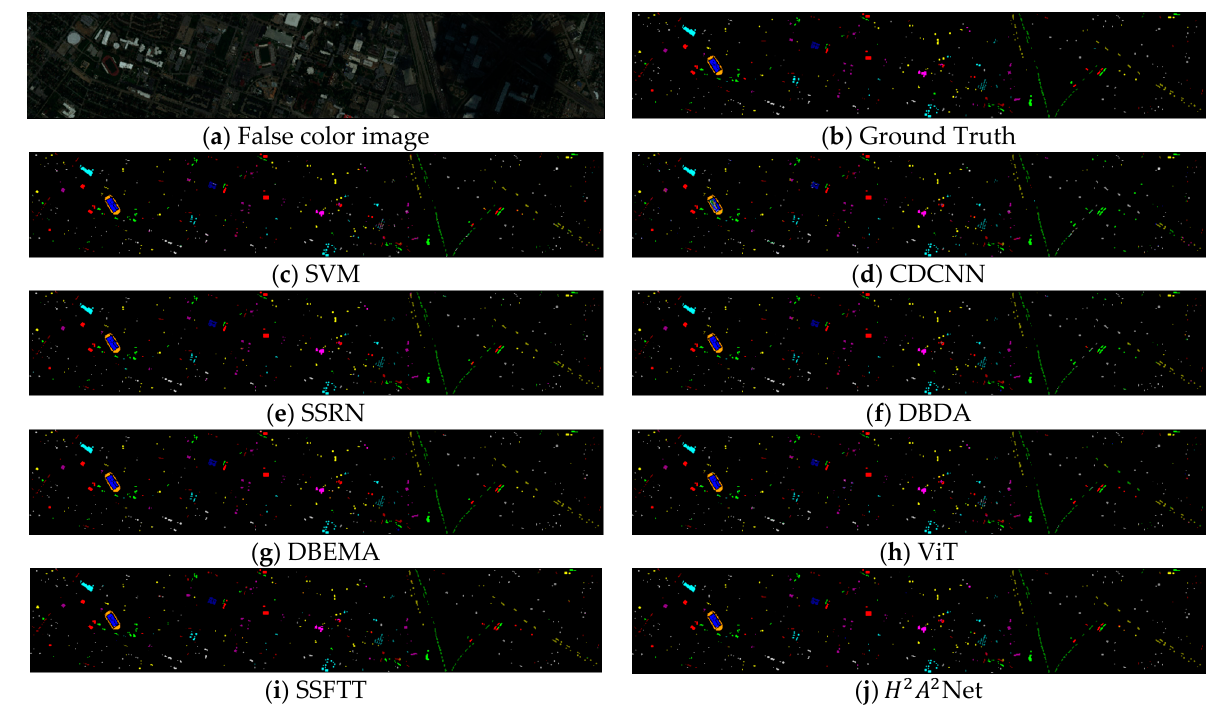
Figure 10. Classification maps achieved via different methods for the HOU dataset. ( a ) False color